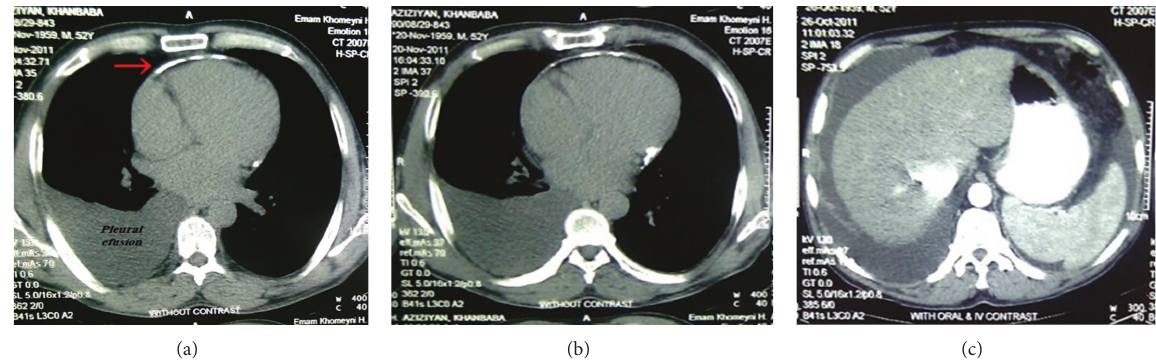
Figure 1: Chest CT showing pleural effusion, cardiac calcification, ascites, and IVC dilation.